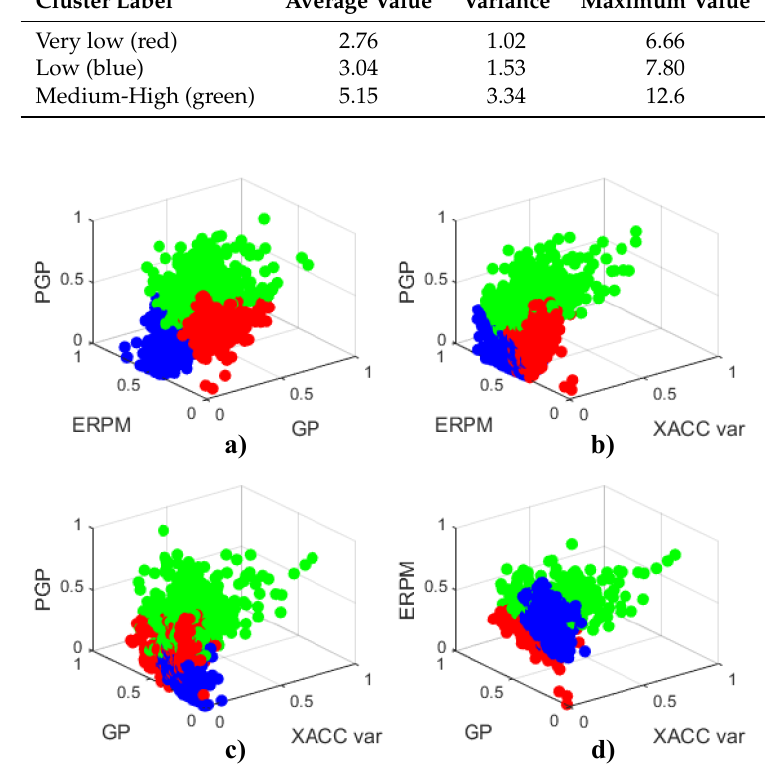
Figure 9. Three-dimensional views of the three-cluster fuel consumption classification results. The clusters were labeled as Very low (red), Low (blue), and Medium-High (green). ( a ) Displays the cluster distribution considering PGP, ERPM and GP. ( b ) Considers PGP, ERPM and XACC